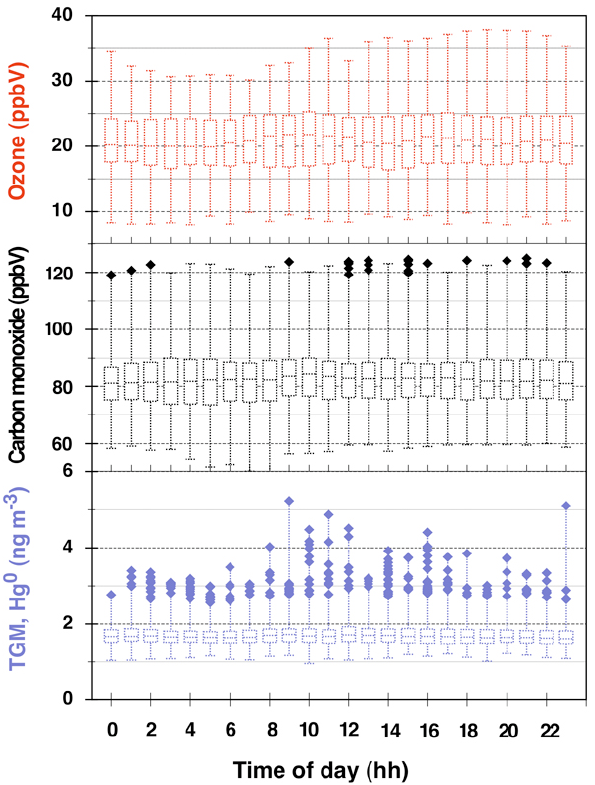
Figure 10 . Diurnal variations of the O 3 , CO and TGM, Hg 0 concentrations summarised as in Table 2. The box assemblies include the mean, the upper and lower 95% confidence intervals and extremes (far outliers) for 1-h per bin diurnally integrated samples. The UTC time data has been recalculated to represent destination local time.